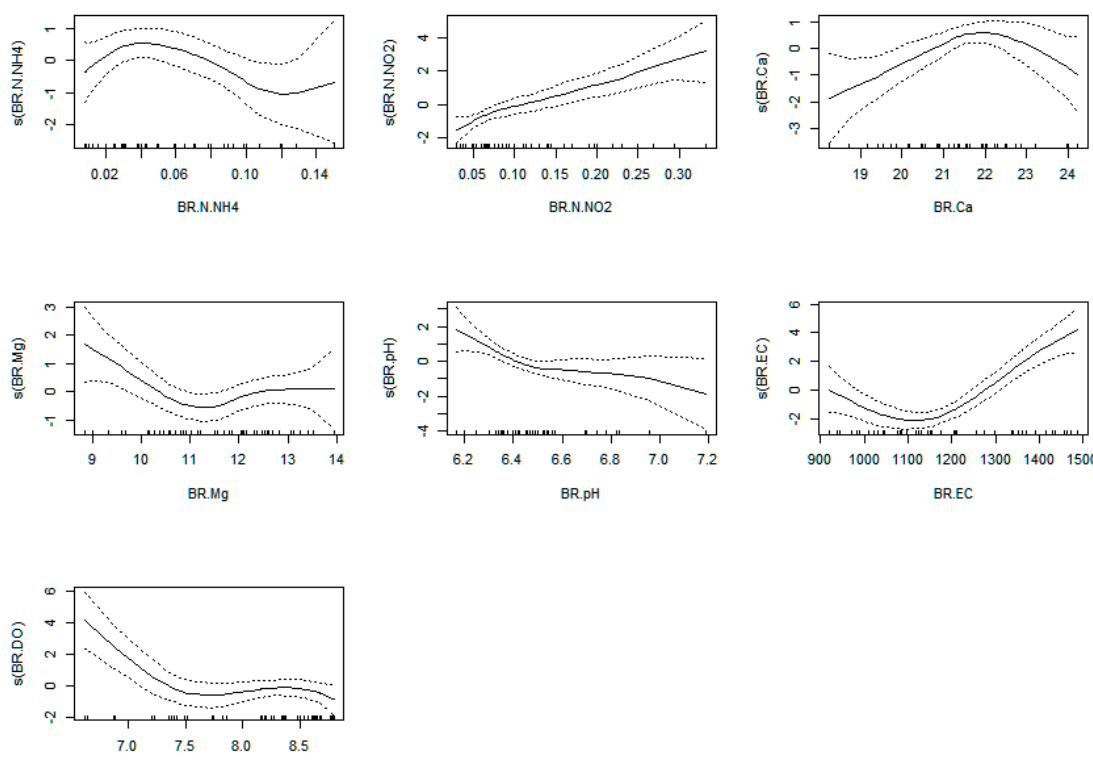
Figure A20. The GAM predictors influence over N-NO 3 for BH experimental variant.